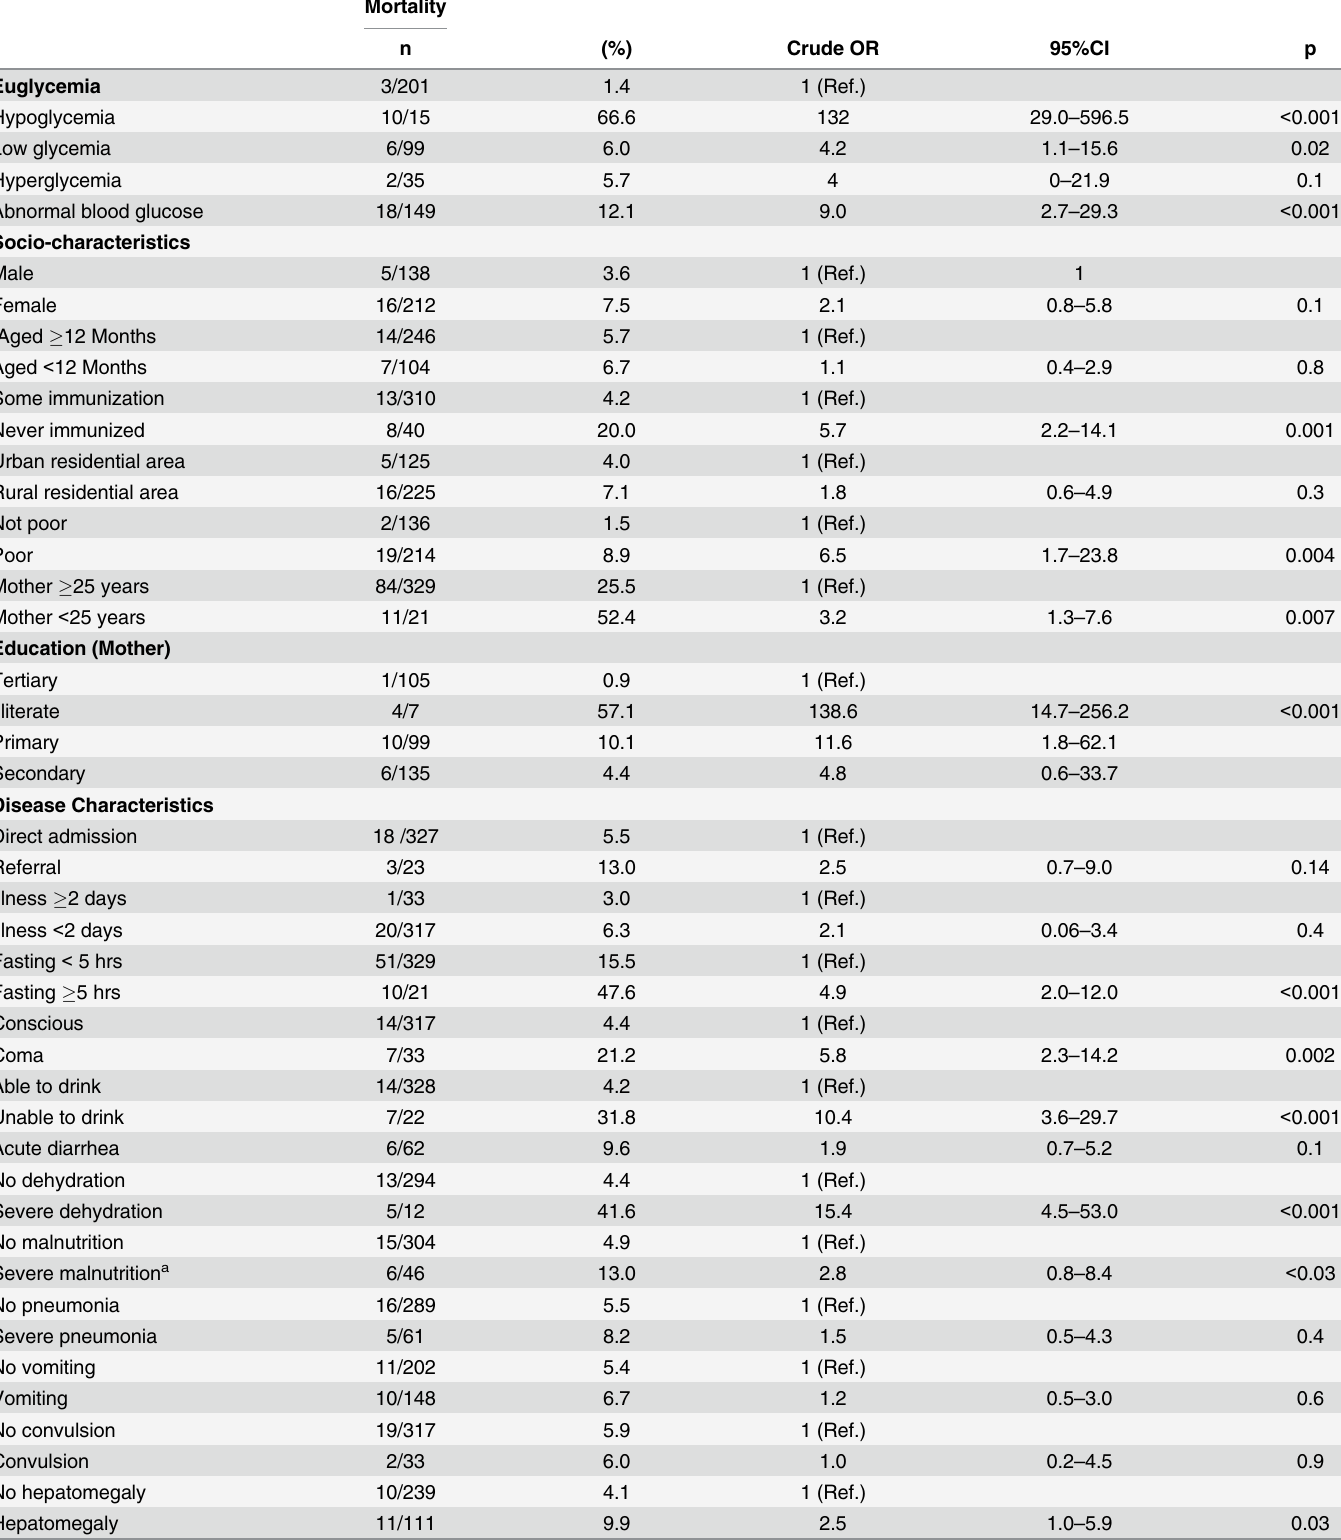
Table 4. Characteristics associated with death for children on admission to Vientiane hospital (univariate